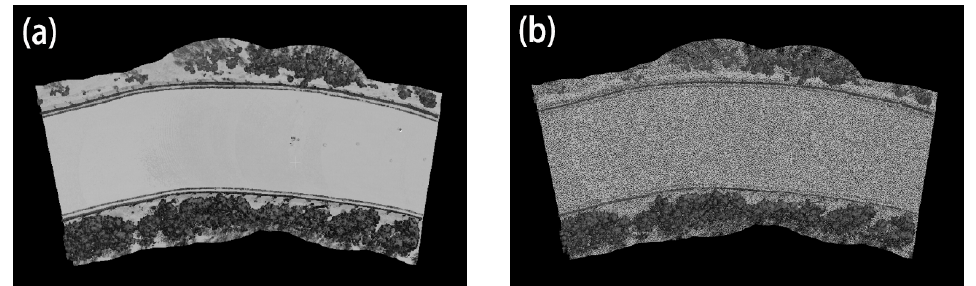
Figure 7. The downsampling results of the first laser point cloud datasets in region A : ( a ) raw data points; ( b ) downsampled points.